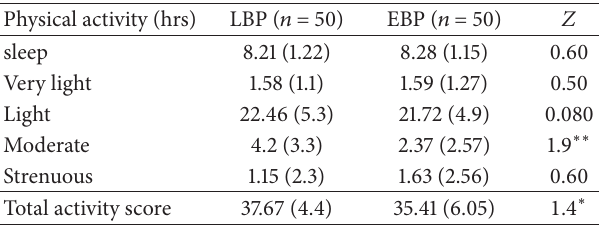
Table 2: Mean and standard deviation of one-day physical activity (hrs/day) and energy expenditure in both boys and girls of LBP and EBP groups.